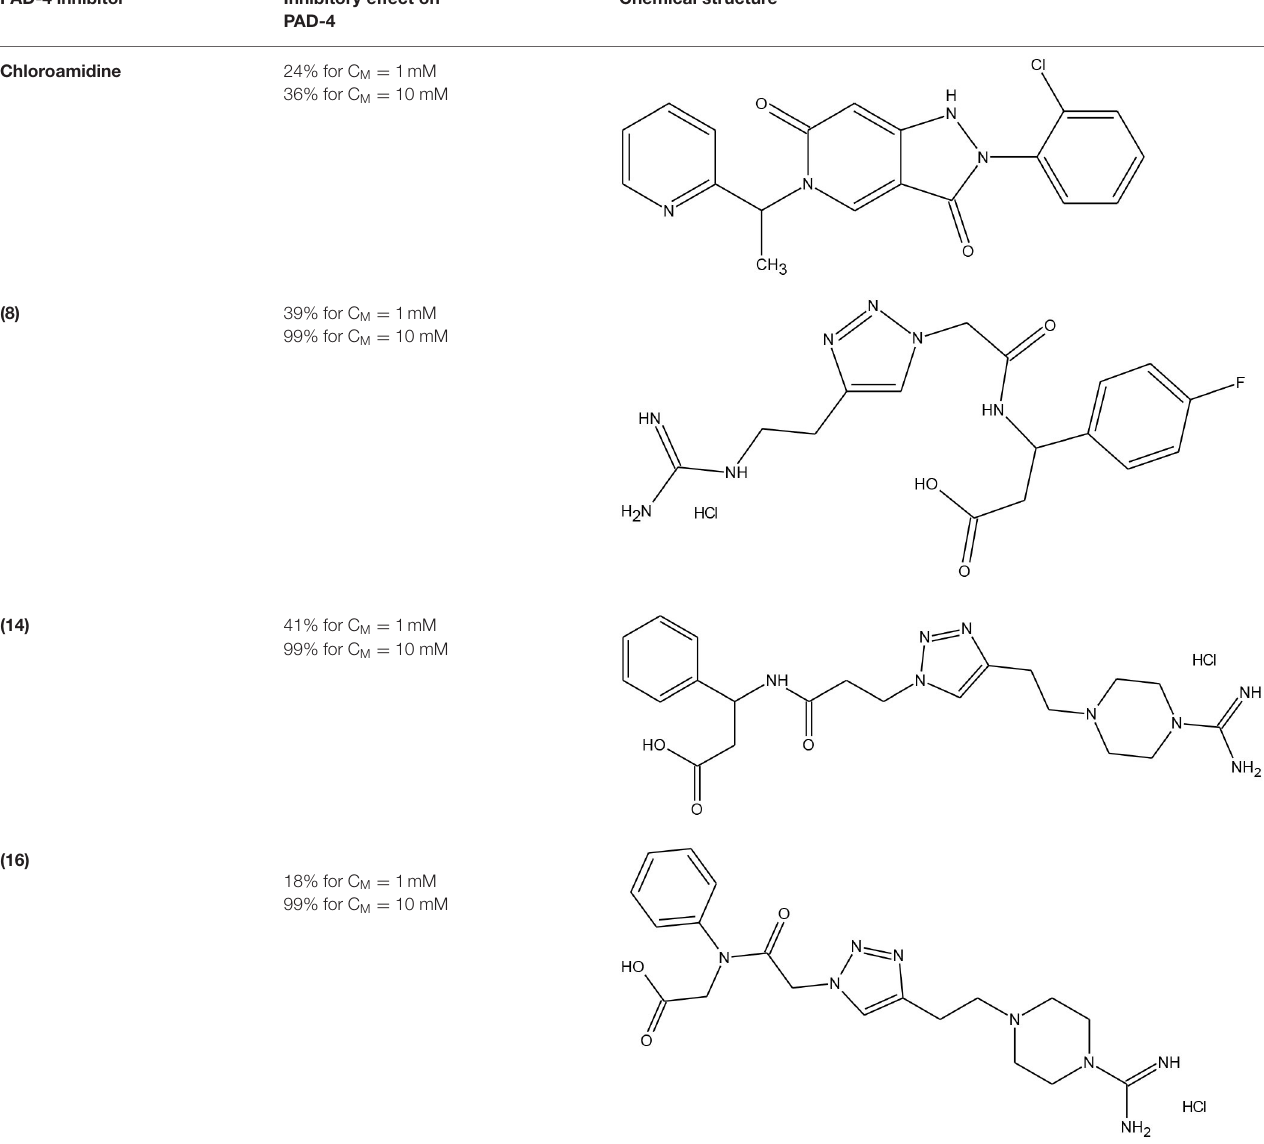
TABLE 5 | The most effective PAD-4 inhibitors: commercially available chloroamidine and three 1,2,3-triazole-modified peptidomimetics 8 , 14 , and 16 (Trabocchi et al., 2015). PAD-4